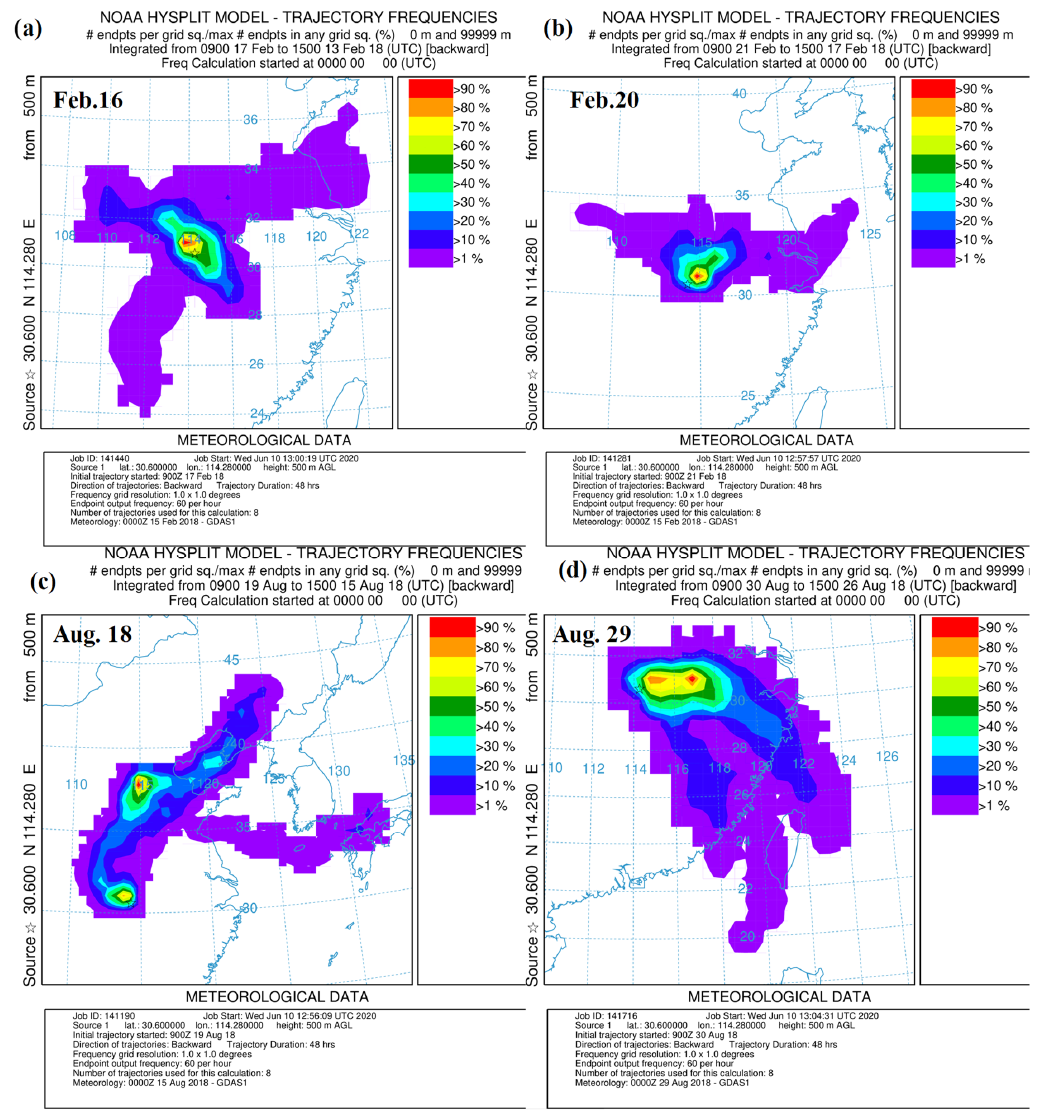
Figure 5. Air mass trajectory frequencies in four typical sampling case. ( a ) the 16 February case, ( b ) the 20 February case, ( c ) the 25 August case, ( d ) the 25 August case.